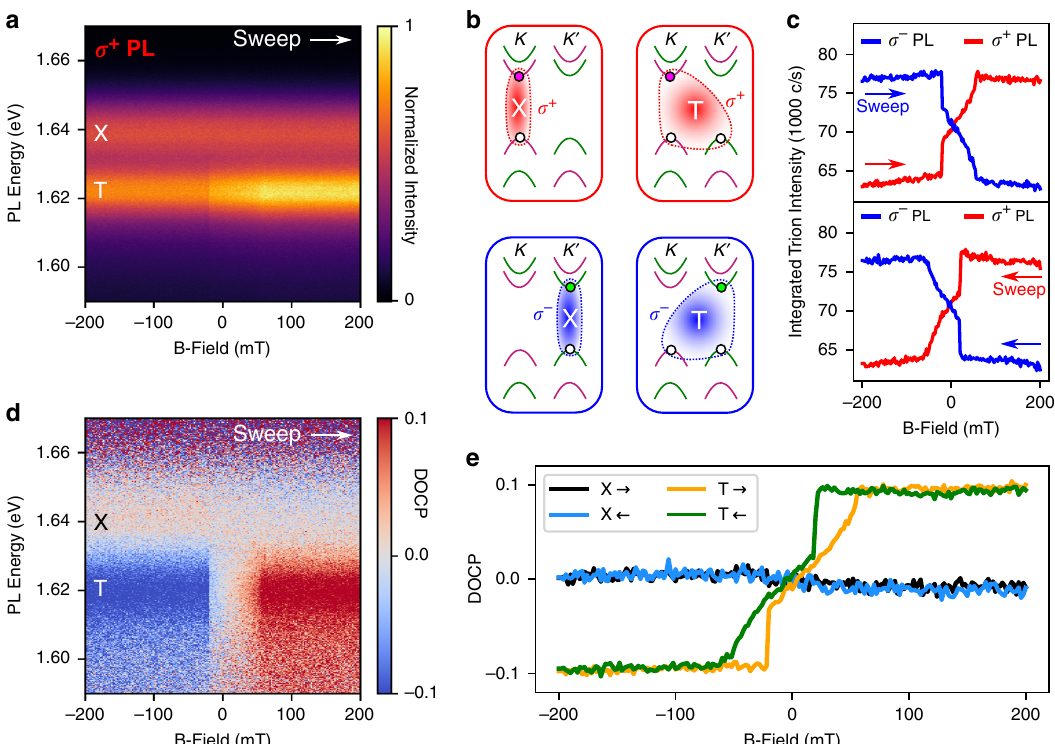
Fig. 2 Magneto-photoluminescence of MoSe 2 /CrBr 3 heterostructures. a Photoluminescence (PL) intensity in σ + circular polarization as a function of photon energy and external B - fi eld, in the forward sweep direction. The neutral exciton (X) and trion (T) are labeled. b Schematics of the electron-hole valley con fi gurations of the two ground-state optically bright neutral excitons and positive trions in monolayer MoSe 2 , which emit either a σ + or σ − polarized photon upon recombination. The pink (green) electron is spin ↑ ( ↓ ), and the hole is white, regardless of spin. Spin-valley locking ties the electron spin to the emission polarization. c Integrated trion PL intensity in both circular polarizations, for the forward (upper panel) and backward (lower panel) B - fi eld sweep directions. d Degree of circular polarization (DOCP) as a function of photon energy and B - fi eld, in the forward sweep direction. e DOCP of the exciton and trion states calculated from integrated intensities, shown for both sweep directions, revealing hysteresis type behavior in the trion. The error in DOCP for this fi gure is ~